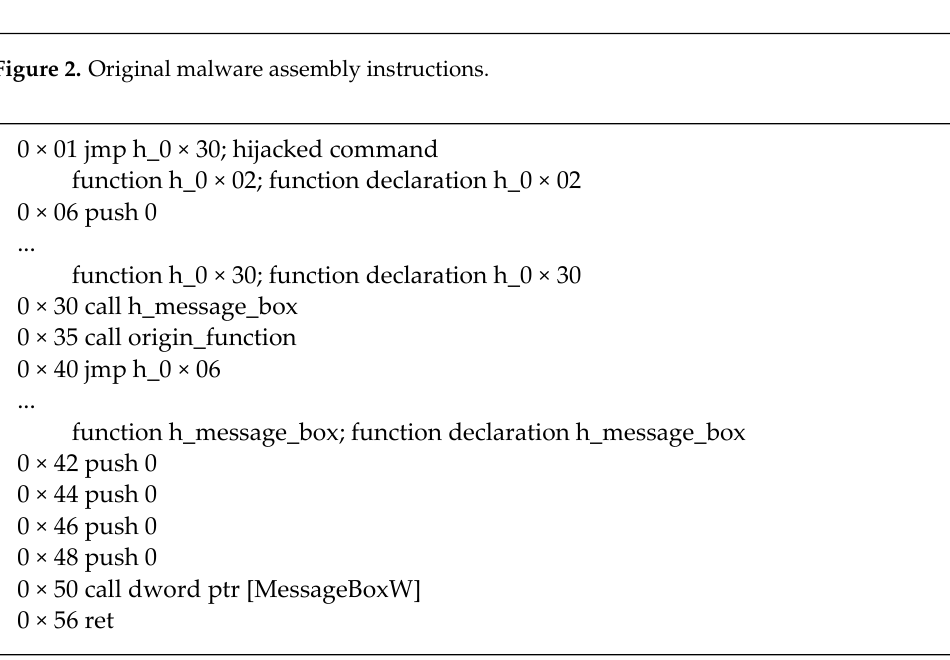
Figure 3. Variant malware assembly instructions.